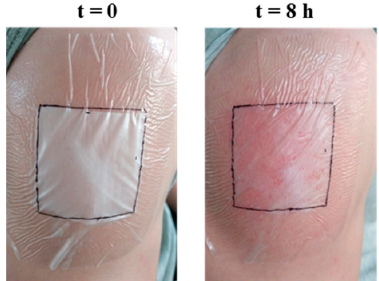
Figure 5. Preliminary assessment of the feasibility of transdermal patches based on experimental nanofibers. Dressings for topical applications produced by electrospinning experimental nanofibers onto adhesive patches were developed and tested for up to eight hours on volunteers’ arms. Representative pictures of their application are shown at both the beginning and the end of the test. After eight hours of treatment, the degradation of the nanofibers and the typical reddening of the skin as a consequence of the action of capsaicin on the surface of the skin were observed.